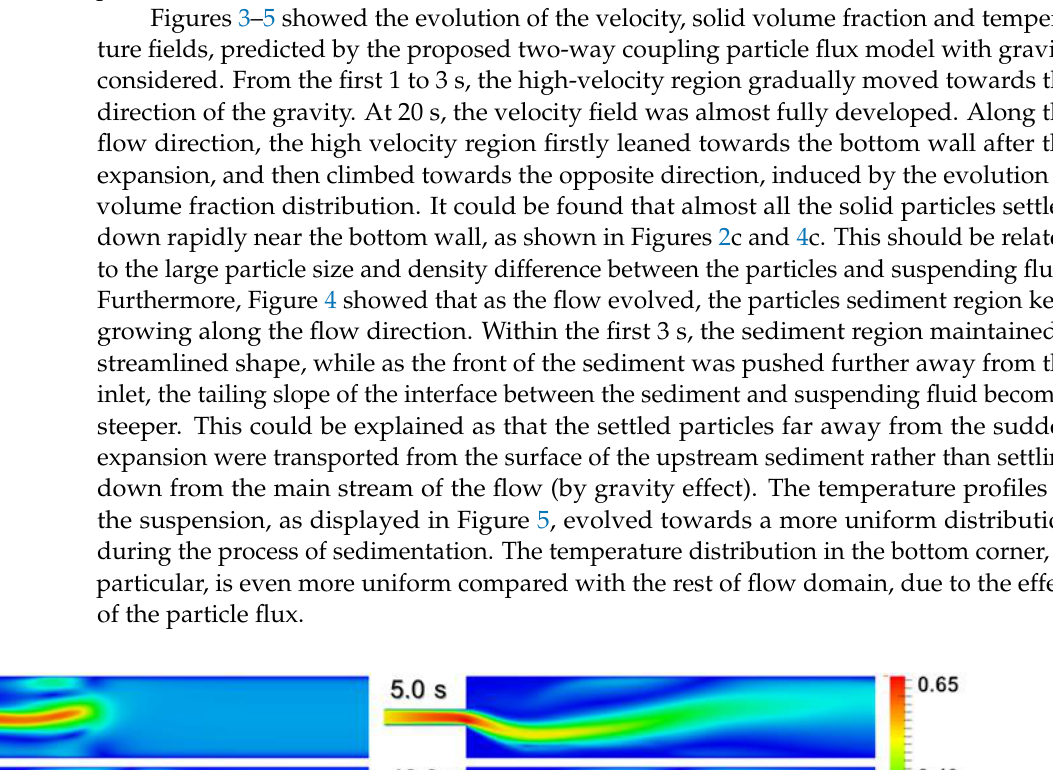
Figure 4. The volume fraction fields of the solid component at different time steps with considering the gravity and using the proposed particle flux model.